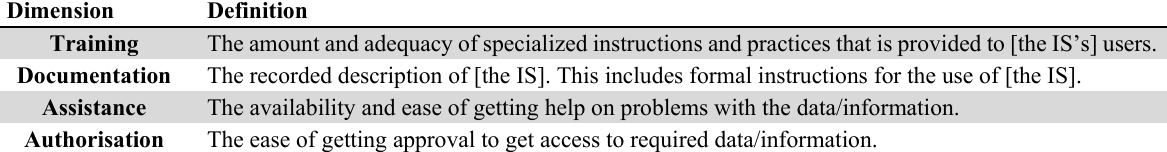
Definitions of the four dimensions of the IS-Support construct